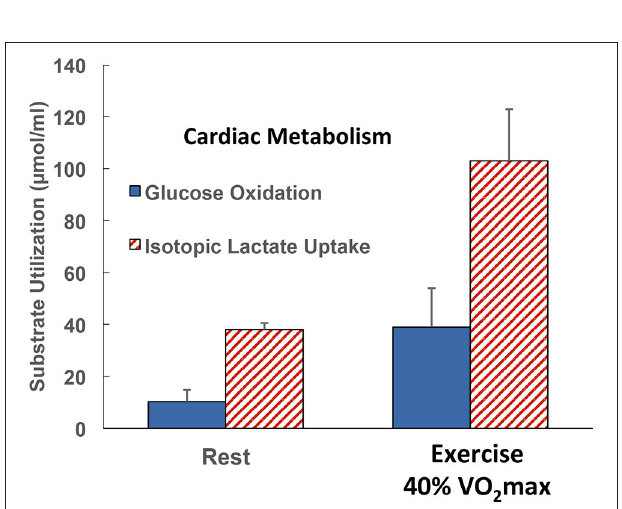
FIGURE 4 | Illustration of the relationships between whole-body glucose rate of disappearance (RdG) and lactate appearance (RAL) during rest, exercise at 40% VO 2 max ( 47), and lactate threshold (55, 91).